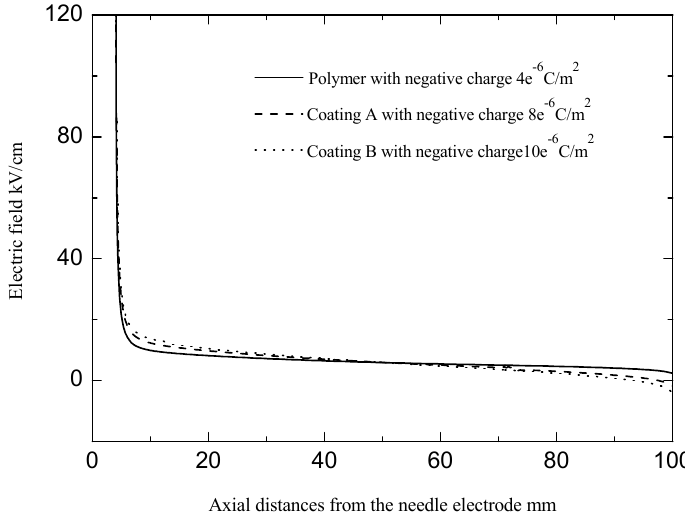
Figure 11. Variation of the electric field in the gap at axial distances.